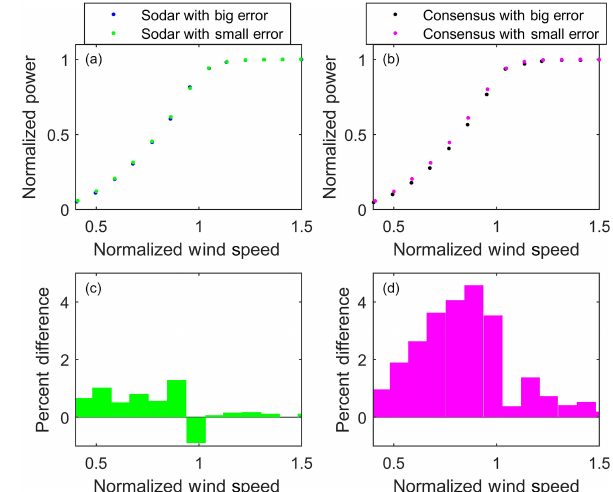
Figure 12. (a, b) Power curves based on binned data for 1ms − 1 wind speed bins across all turbines and (c, d) percent difference be- tween binned power from small wind direction errors to large wind direction errors. Positive percent difference indicates more power is generated when wind direction errors are small. Panels (a, c) are based on comparisons between turbine wind vanes and the sodar, and (b, d) are based on comparisons between the turbine wind vanes and the consensus